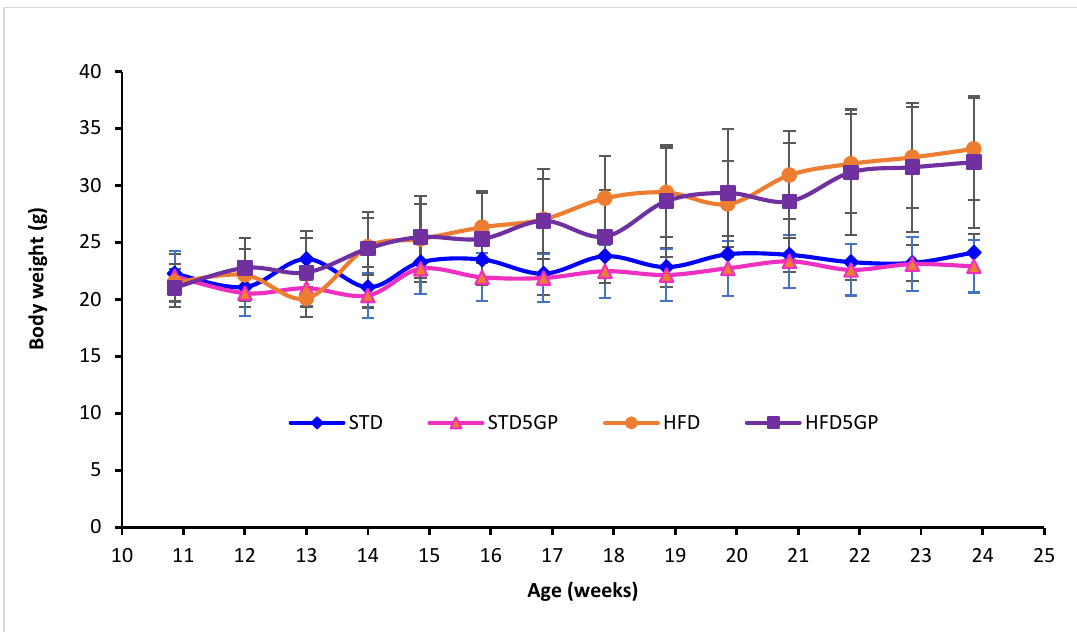
Figure 1. Dietary fat content but not grape supplementation affects mouse body weight. Body weights of mice from the beginning of the diet schedule (11 weeks-of-age) for the next 13 weeks (24-weeks-of-age) on standard diet (STD) ( n = 10), standard diet supplemented with 5% grape powder (STD5GP) ( n = 10), high-fat diet (HFD) ( n = 10), or high-fat diet supplemented with 5% grape powder (HFD5GP) ( n = 10). Prior to 11 weeks of age, all mice were provided with the STD. Mouse body weights were monitored weekly. The body weight of the high-fat diet groups was greater than that of the standard diet groups [two-way ANOVA: F (1, 36) = 53.91, p < 0.001]. Within the respective groups, grape supplementation did not significantly alter body weight. Additional details are presented in the text and in Table